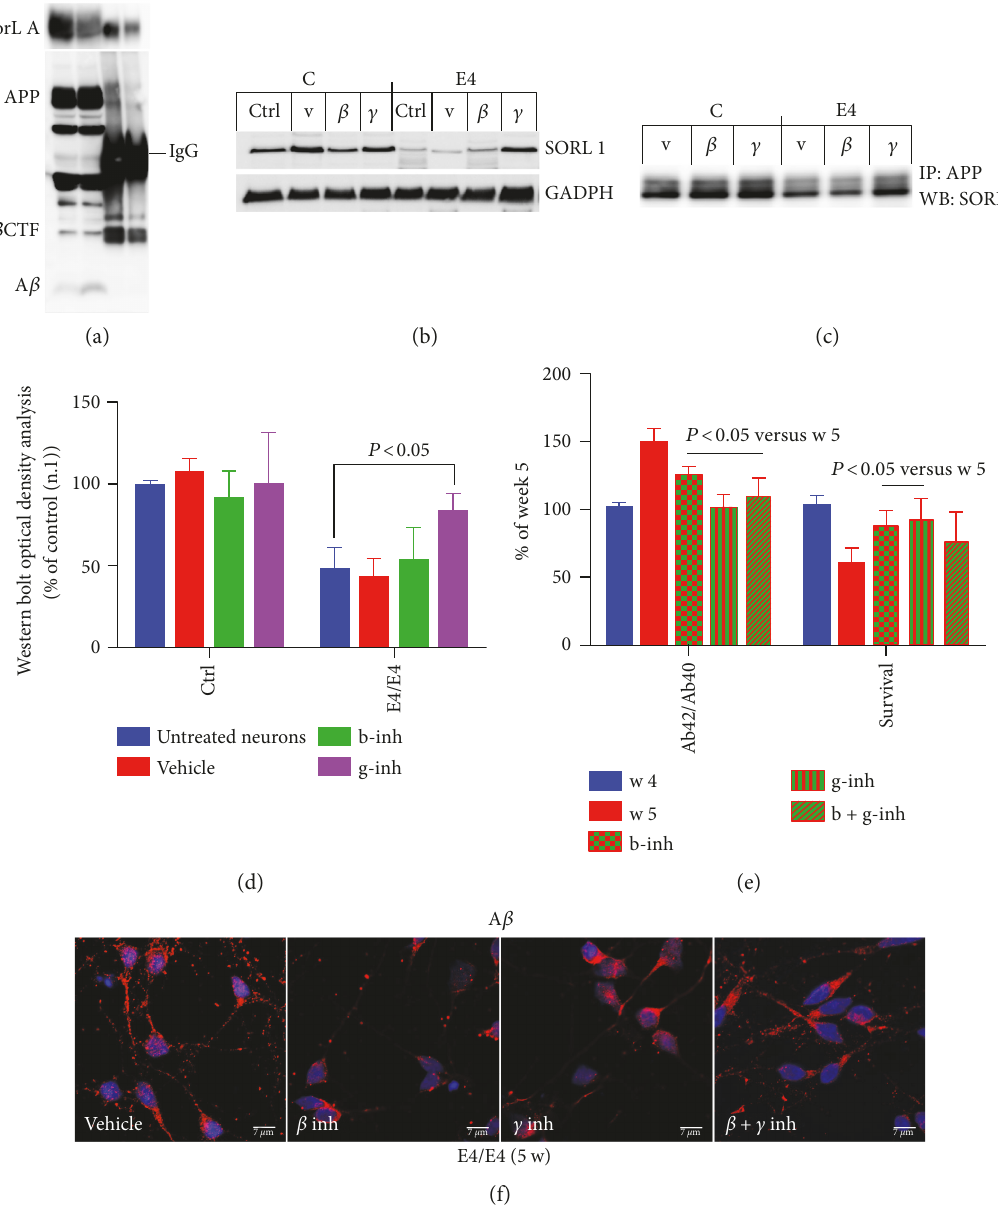
Figure 3: SORL1 binding to APP is decreased in E4/E4 neurons. (a) Protein samples from control (C) and E4/E4 (E4) neurons, after fi ve weeks in culture, were immunoprecipitated with mouse anti-SORL1 antibody (co-IP SORL1) and analyzed with rabbit anti-APP. TL, total lysate; Co-IP, immunoprecipitate. (b) WB analysis of control (C) and E4/E4 (E4) neurons after fi ve weeks in culture (Ctrl, untreated neurons) with vehicle (V, DMSO 0.01%) β – (b-inh, 250 μ M), and γ – (g-inh, 50nM) secretase inhibitors. (c) The same samples were immunoprecipitated with anti-APP antibody and analyzed with anti-SORL1 by WB. Densitometric analysis (OD) is reported in (d) n = 4 ; one-way ANOVA with post hoc Tukey ’ s test. P < 0 05 versus untreated E4/E4 neurons. (e) To counteract A β 42 production, neurons were exposed to β – (b-inh, 250 nM), γ – (g-inh, 50 nM), and β + γ (b+ g-inh) secretase inhibitors after four weeks of plating (blue histogram), and A β 42 levels were assessed one week later, fi ve weeks (red histograms) by ELISA. (f) Confocal microscopy analysis of E4/E4 neurons incubated with or without secretase inhibitors and stained with an anti-A β antibody. Nuclei are marked in blue. Note that the anti-A β antibody also detects full length APP. Pictures are representative of four experiments ( n = 4 ) performed in triplicate. Scale bar: 7 μ m. Media with or without inhibitors were refreshed every two days. The level of A β 42 (expressed as the ratio of A β 42/40) and the extent of intact NeuN-positive nuclei (survival) are reported in (e). Each data point is the mean ± SEM of triplicate determinations of three independent experiments ( n = 3 ) and is expressed as the percentage of values from E4/E4 neurons after 4 weeks of